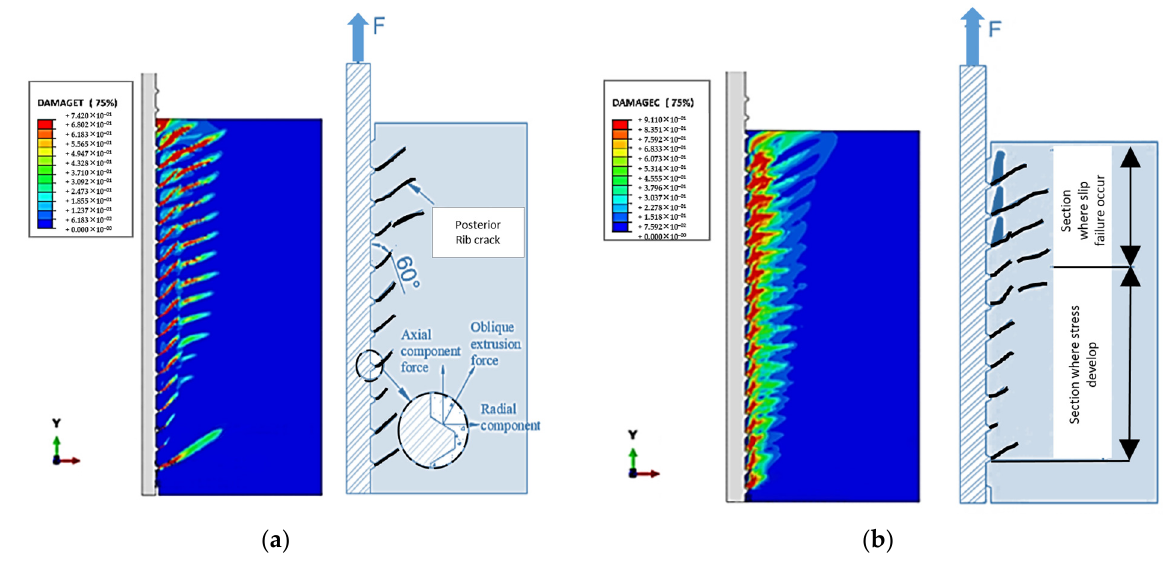
Figure 30. ( a ) Development of concrete crack failure at the SCI. ( b ) Concrete failure at the interface [1].